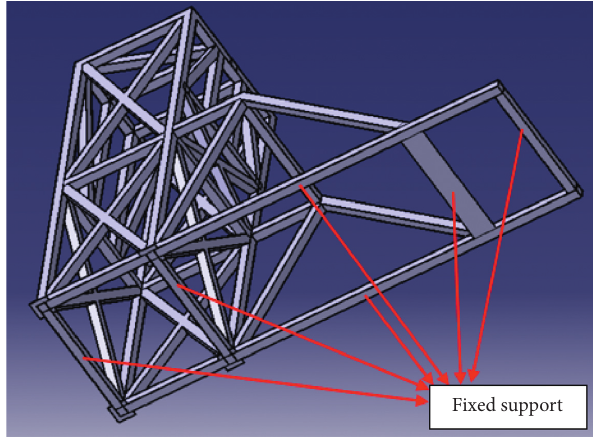
Figure 5: Constraints for the test rig